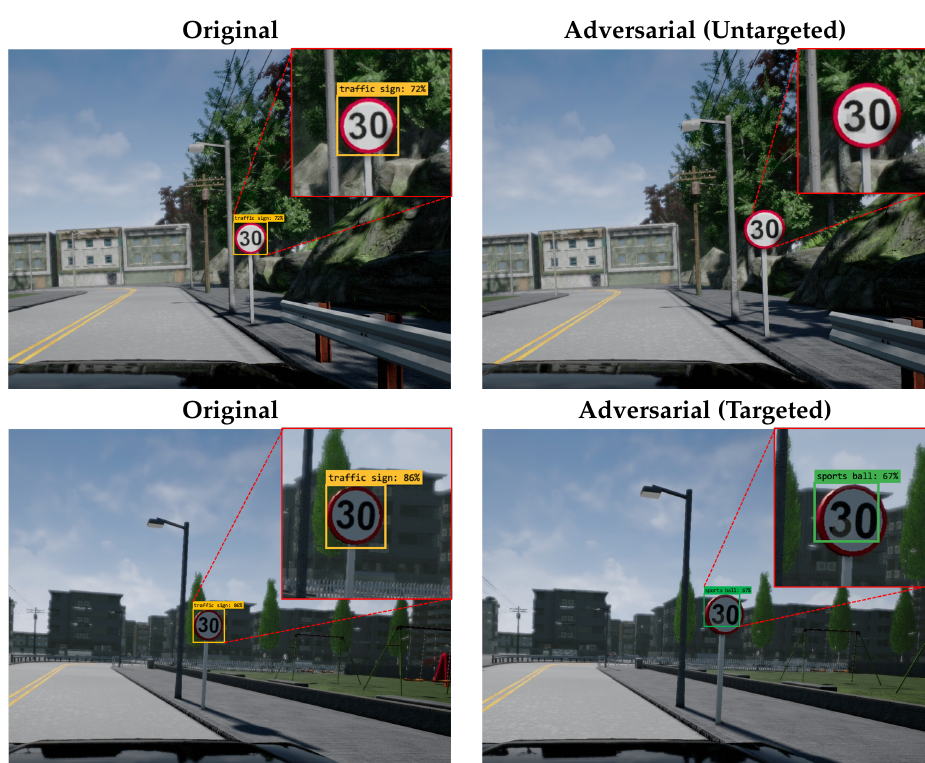
Figure 5. Samples of original images and adversarial examples for traffic